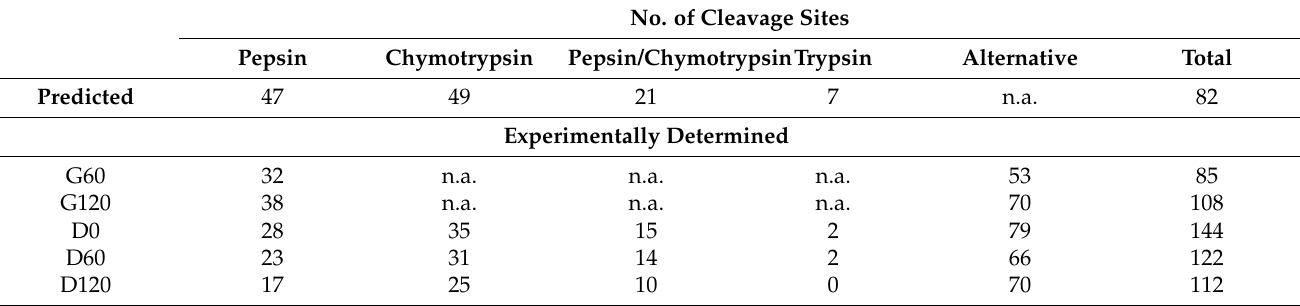
Table 1. Predicted and experimentally determined cleavage sites for the LMW-GS allergen B2Y2Q7 throughout simulated digestion. ‘n.a.’ not applicable. The specificity models used for prediction were set as follows: pepsin—pH > 2; chymotrypsin—low specificity; trypsin—default. No. of Cleavage Sites